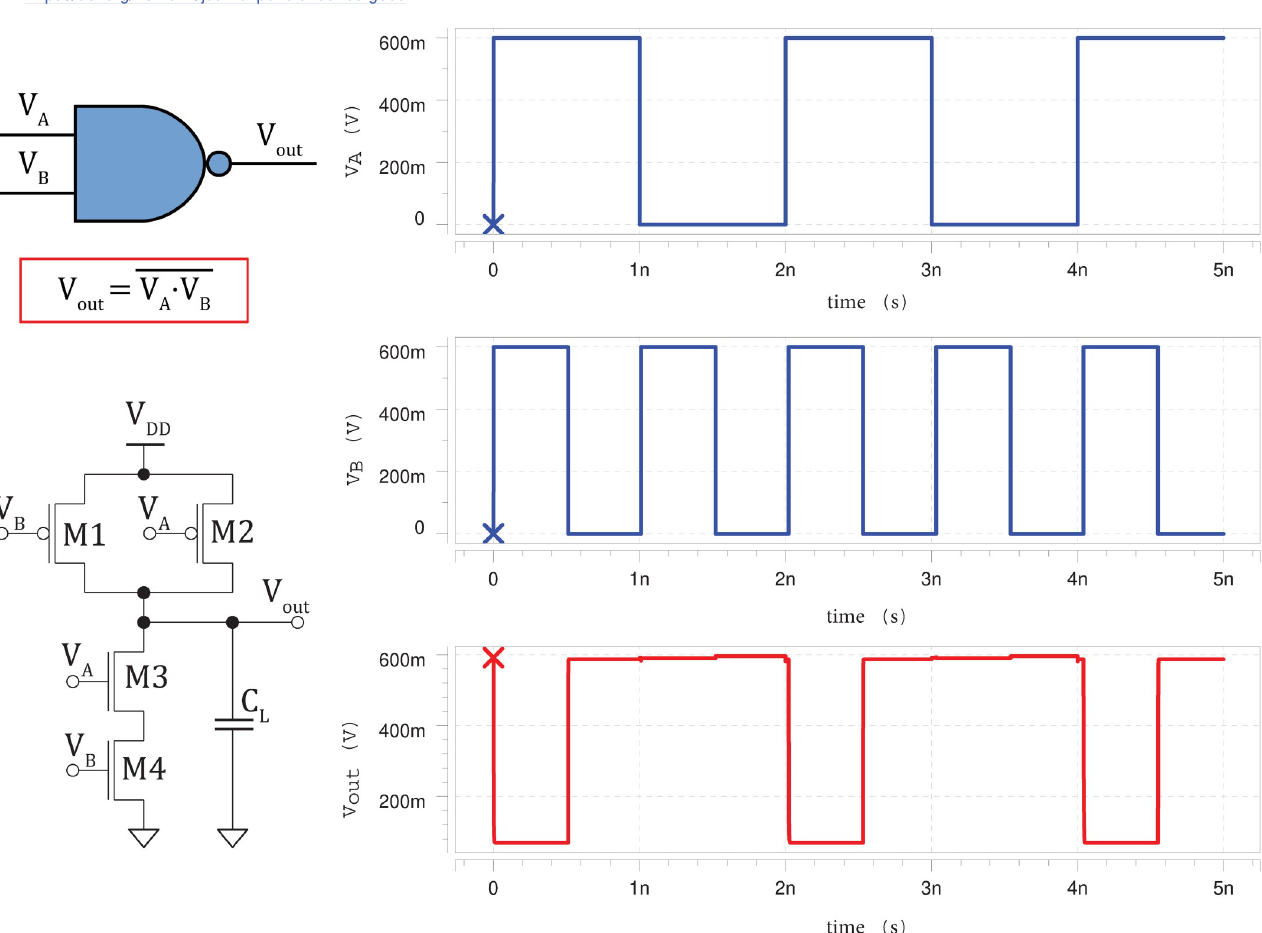
Fig 6. Schematic circuit diagram of silicene-based 2-input NAND gate ( L int = 1 μm ) with its input (blue) and corresponding output waveforms (red).